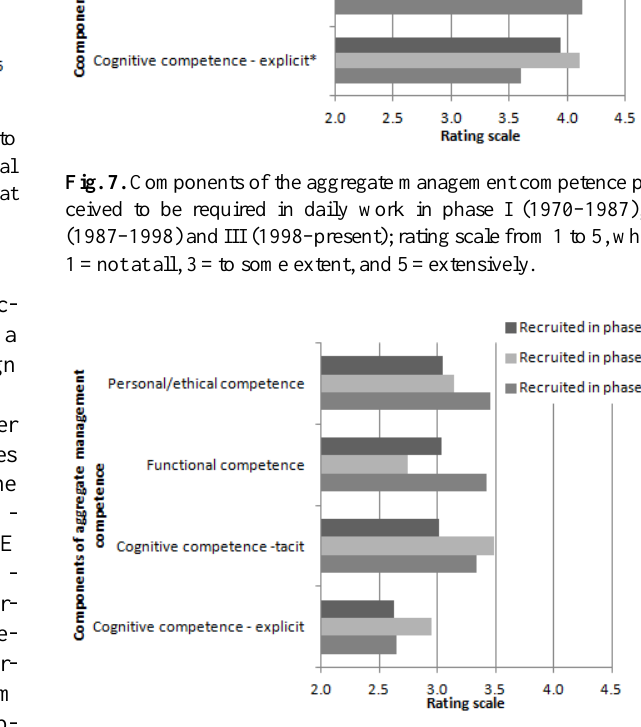
Fig. 8. Components of the aggregate management competence